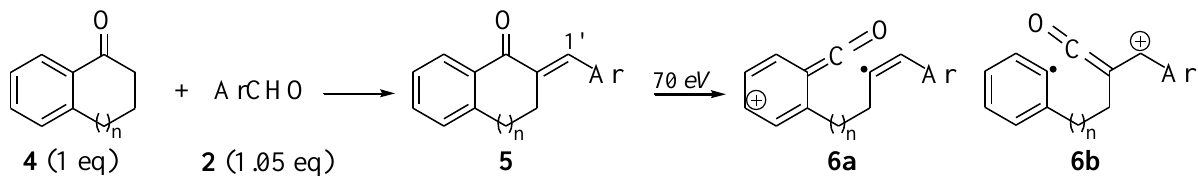
Table 3. Comparison of yield using different reagents, δ of H 1 ′ and m/z of [M] +· in 5a – m .